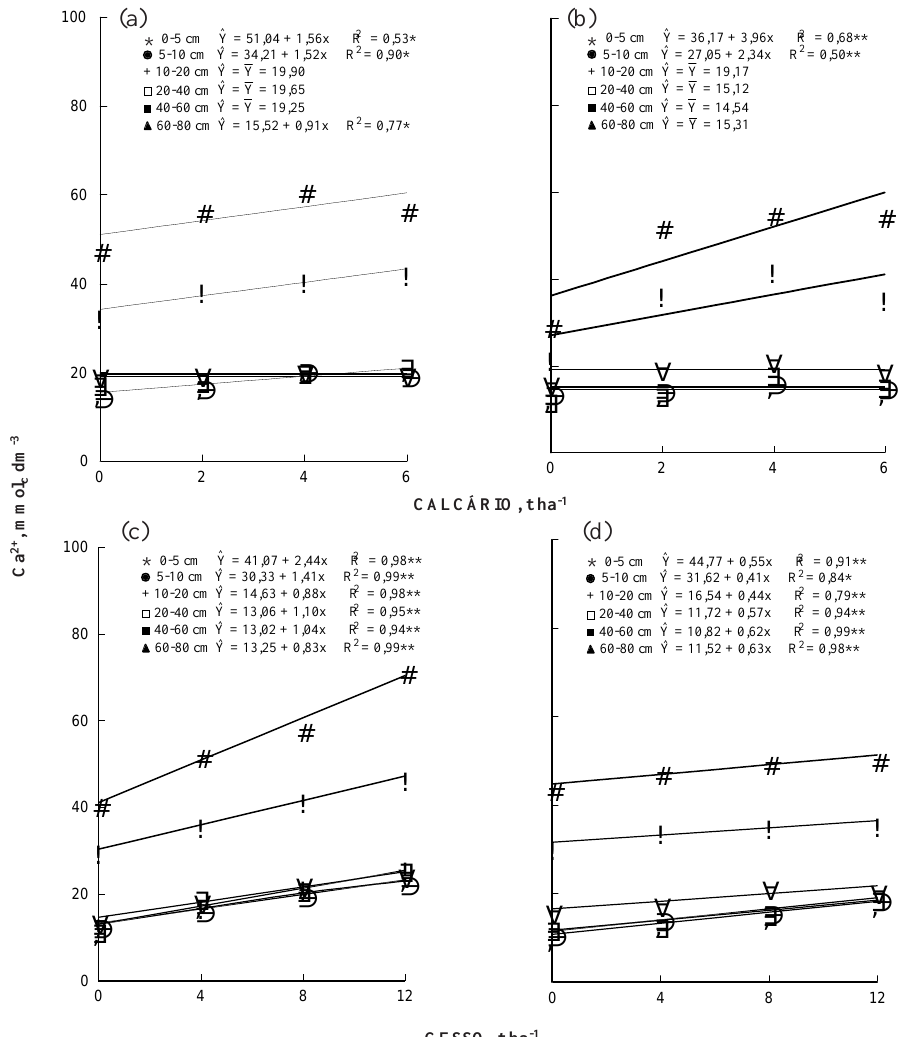
Figura 3. Efeito de doses de calcário, após 18(a) e 40(b) meses, e de gesso, após 14(c) e 36(d) meses, nos teores de Ca trocável, em diferentes profundidades. (a e b: médias de quatro doses de gesso; c e d: médias de quatro doses de calcário). *, ** significativos a 5 e 1%,